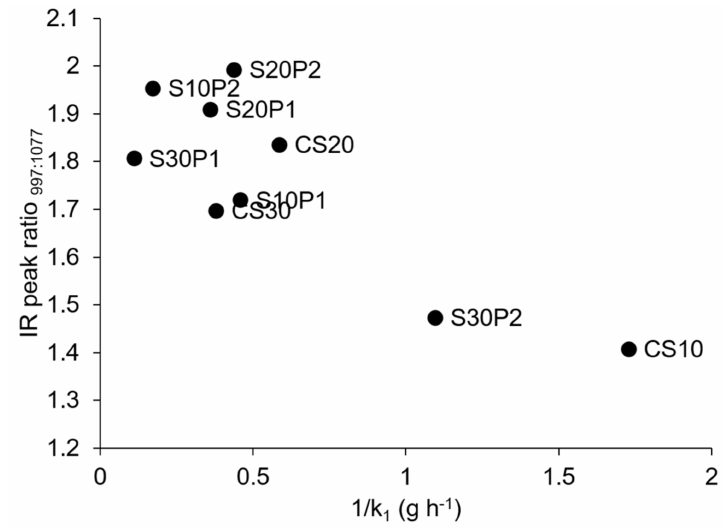
Figure 6. Comparisons of IR peak ratio 997:1077 and inversed Peleg rate